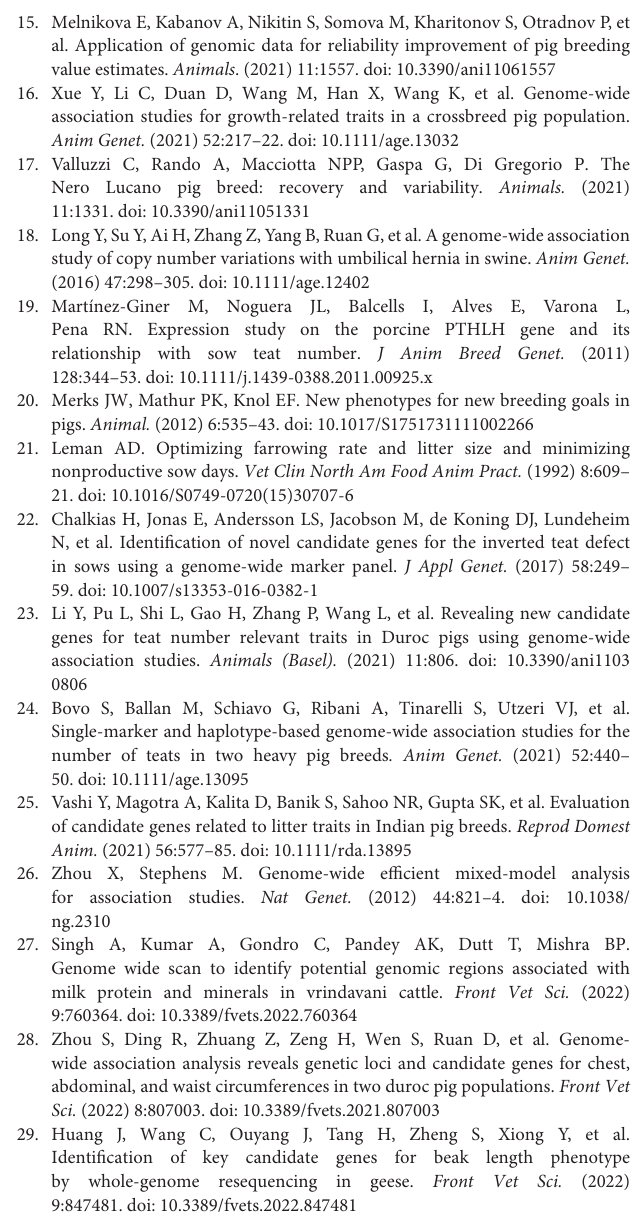
Supplementary Figure S1 | The Manhattan plots obtained in the GWAS with teat number traits. The red line identifies the cut-off for suggestive significance. Red spots identify SNPs with suggestive significance. Traits, from the inner to outer lanes are the teat numbers on the left side (LTN), the teat numbers on the right side (RTN), total number of teats (TTN), and the minimum number of teats (MINTN). Supplementary Figure S2 | The top 10 QTLs in common